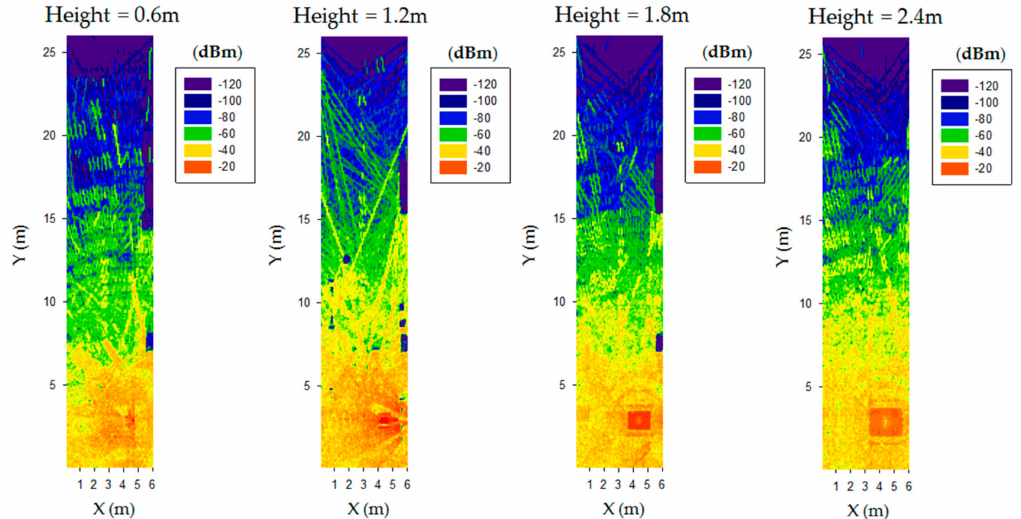
Figure 11. Estimation of the received power levels, obtained with the in-house 3D ray launching simulation. Results were obtained for the complete volume of the scenario and have been particularized for the case of 2D height planes of 0.6 m, 1.2 m, 1.8 m and 2.4